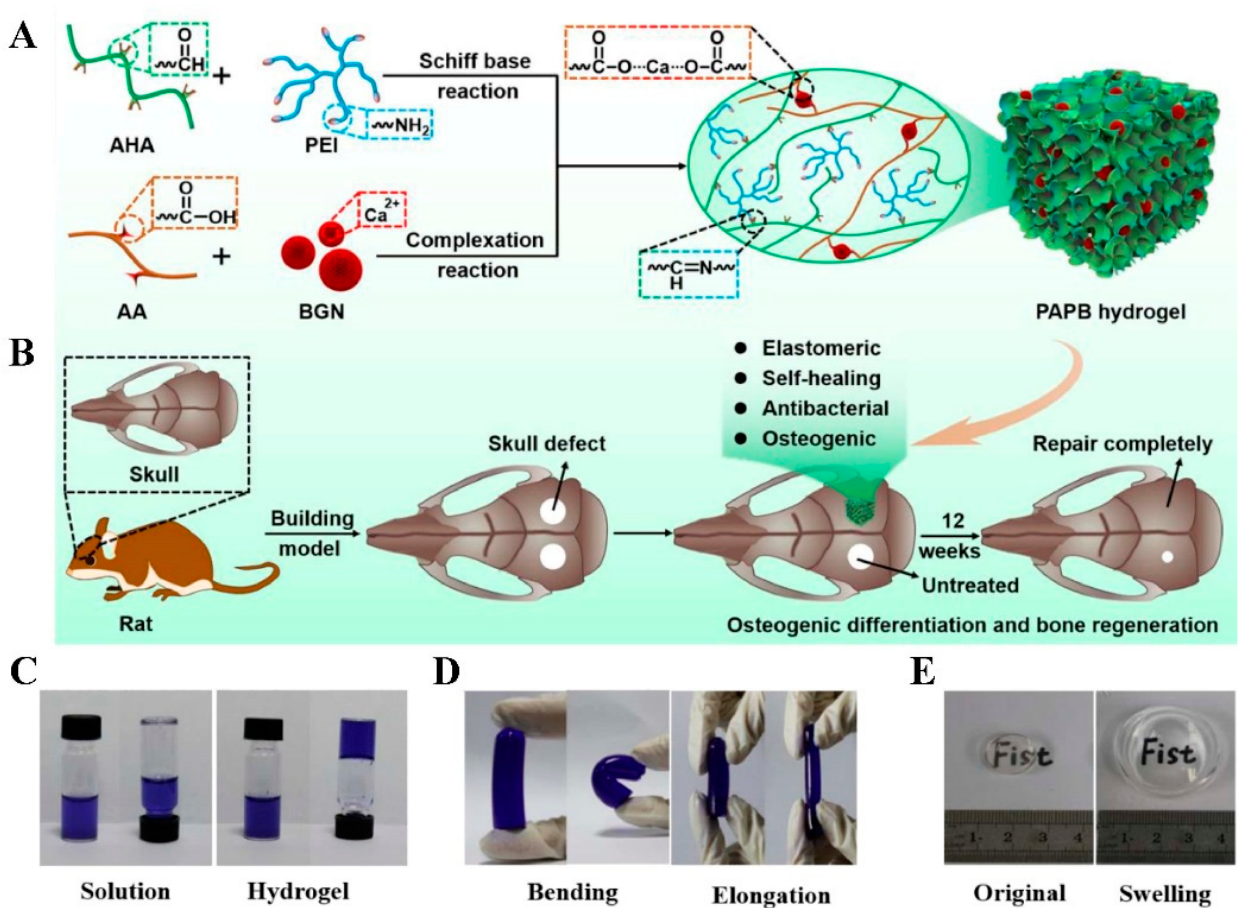
Figure 5. Schematic illustration showing the synthesis process of multifunctional PAPB hydrogel and the effective application. ( A ) The synthesis process of multifunctional PAPB hydrogel, ( B ) potential biomedical applications of multifunctional PAPB hydrogel; ( C ) Intuitive optical images of before and after gelation; ( D ) Intuitive optical images of bending and elongation; ( E ) Intuitive optical images of before and after swelling. AA, acrylic acid (Reprinted with permission from Ref. [187] Copyright 2022, Elsevier.